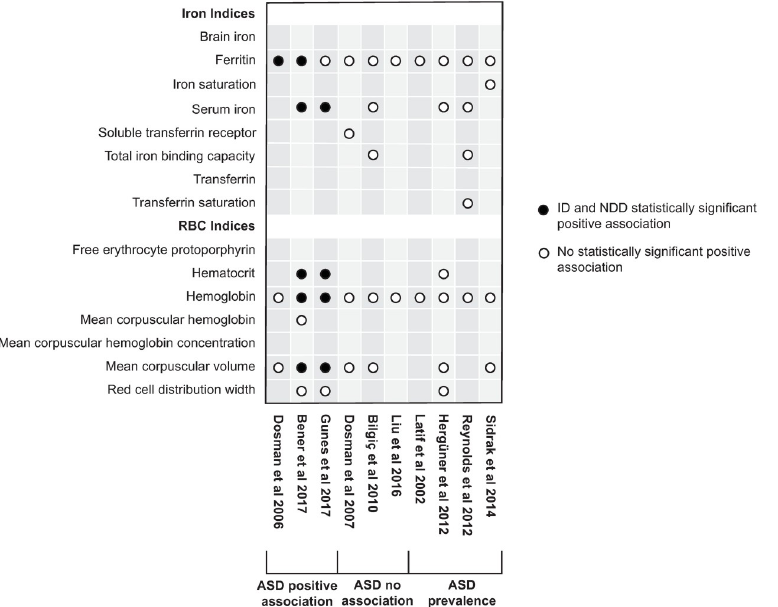
Fig 5. Overview of biomarkers used in ASD association studies.